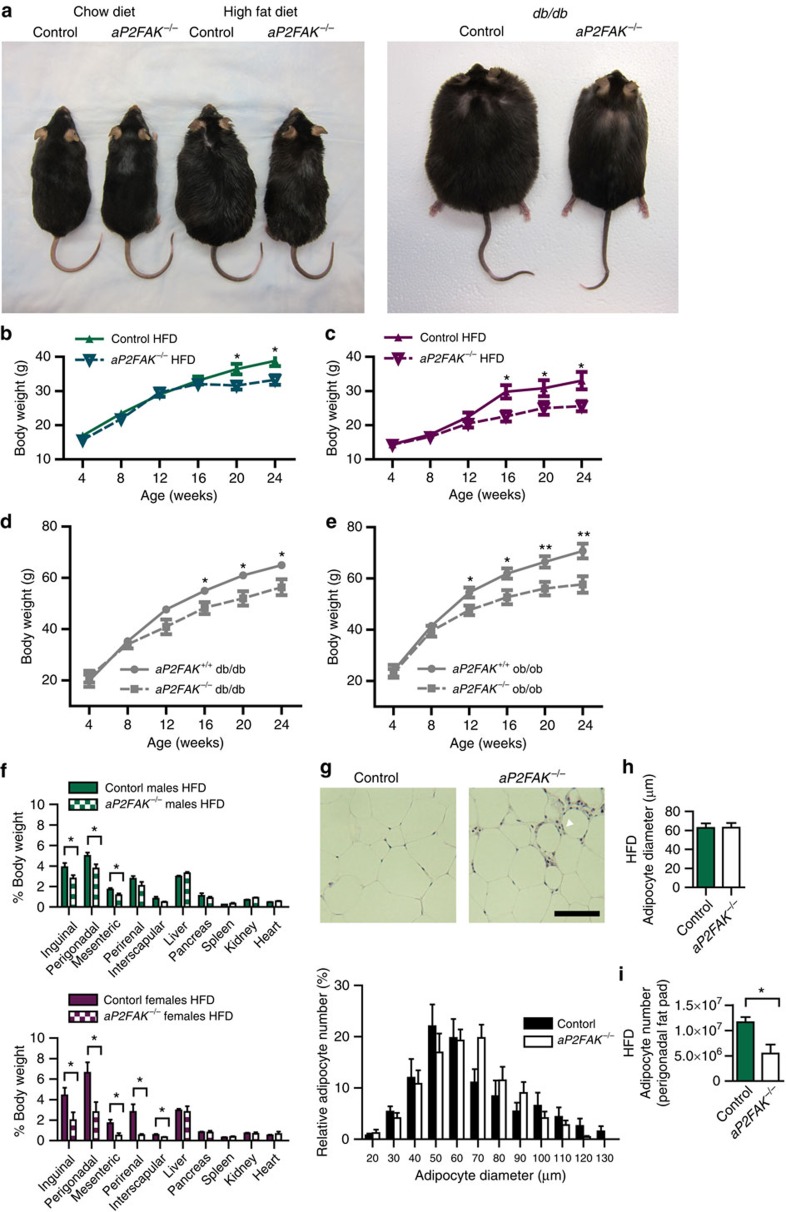
Disruption of FAK impairs adipose tissue expansion with caloric excess.(a) Photograph of 24-week-old littermate control and aP2FAK−/− mouse fed chow or HFD for 16 weeks, and littermate control aP2FAK+/+
db/db and aP2FAK−/−
db/db mouse. (b–e) Body weight of male (n=12) (b) or female (n=8) (c) mice fed HFD starting at 8 weeks of age or mice on db/db (n=10) (d) or ob/ob (n=8) (e) genetic background. (f) Body composition expressed as per cent total body weight in 20- to 24-week-old male (green) and female (purple) mice fed HFD diet for 12–16 weeks (n=6). (g–i) Perigonadal WAT sections stained with haematoxylin and eosin (H&E) (scale bar, 100 μm; arrows indicate macrophage crown-like structures) with adipocyte size distribution (g), average adipocyte diameter (h) and calculated total adipocyte number (i) from 20- to 24-week-old mice fed HFD for 12–16 weeks (n=4 mice). Data are mean±s.e.m. *P<0.05 and **P<0.01 by Student's t-test between means.